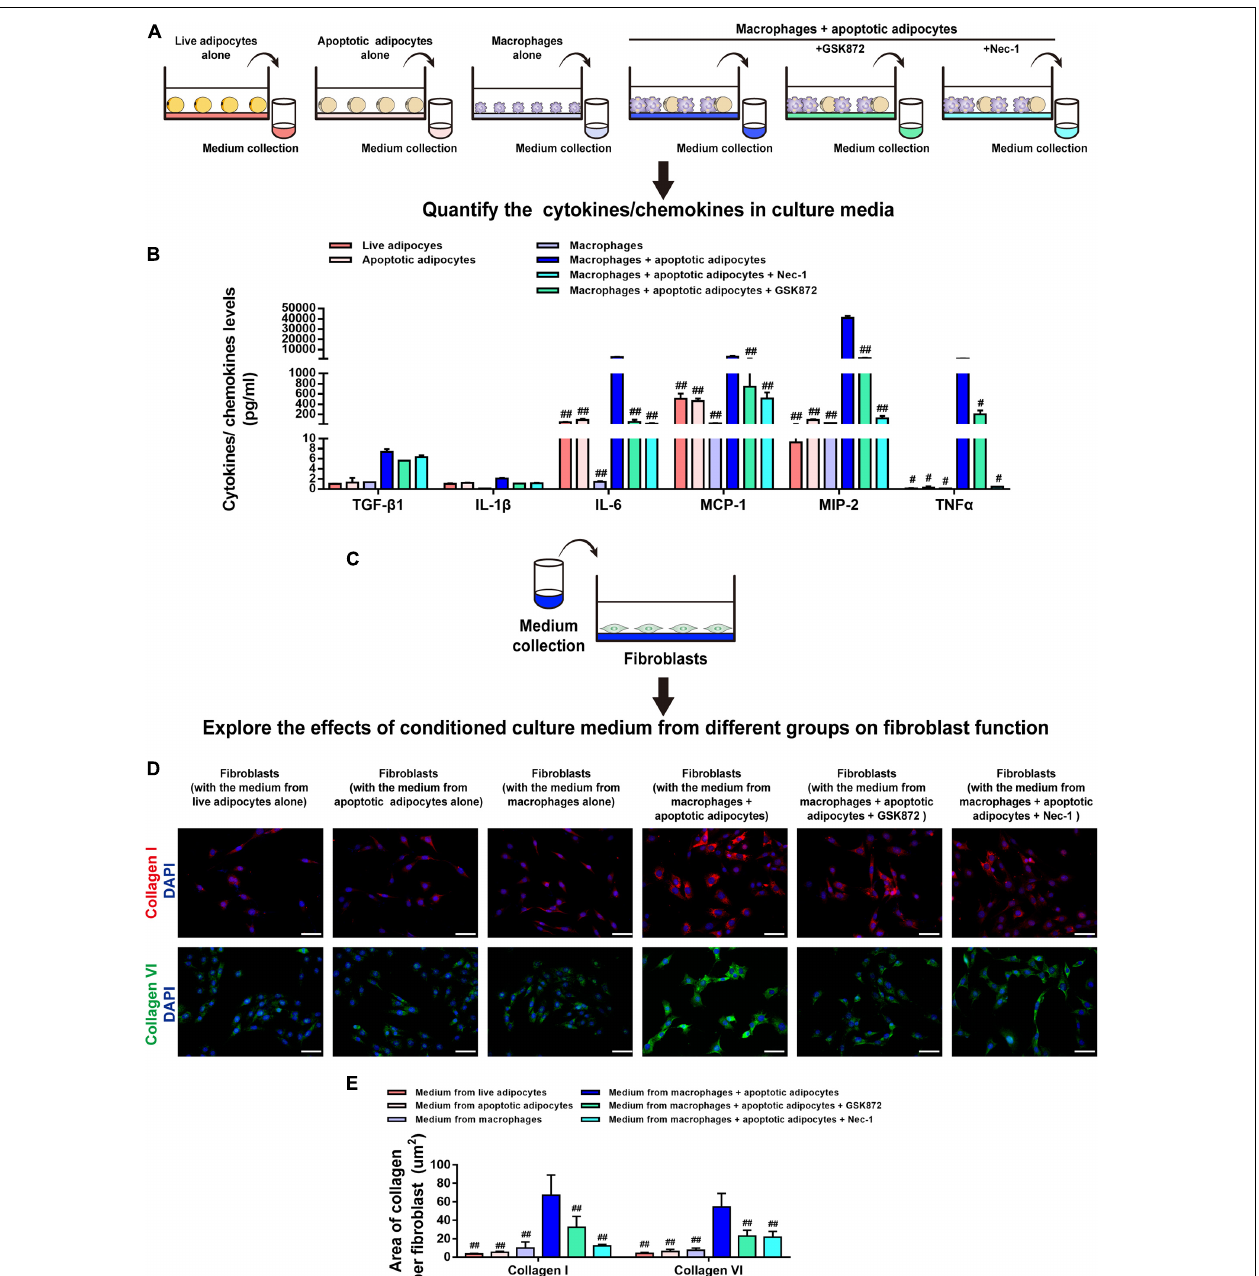
FIGURE 7 | Necroptosis of MFCs induces collagen expression in fibroblasts via a paracrine mechanism. (A,B) MILLIPLEX MAP assays were used to detect the expression levels of cytokines/chemokines in conditioned media collected from six groups, including adipocytes (live or apoptotic), RAW 264.7 macrophages, and CLS cultured cells incubated in the presence or absence of a necroptosis inhibitor (Nec-1 or GSK872). (C) Fibroblasts were treated with conditioned media collected from the six groups. (D) Immunofluorescence staining of collagen I and collagen VI in fibroblasts to investigate the paracrine effect of the culture media from various groups on fibroblasts. (E) Quantification of the collagen I- and collagen VI-positive areas per fibroblast. Scale bars = 50 µ m. Data are presented as the mean ± SD. # P < 0.05, ## P < 0.01 compared with the CLS cell culture model group incubated without necroptosis inhibitors.